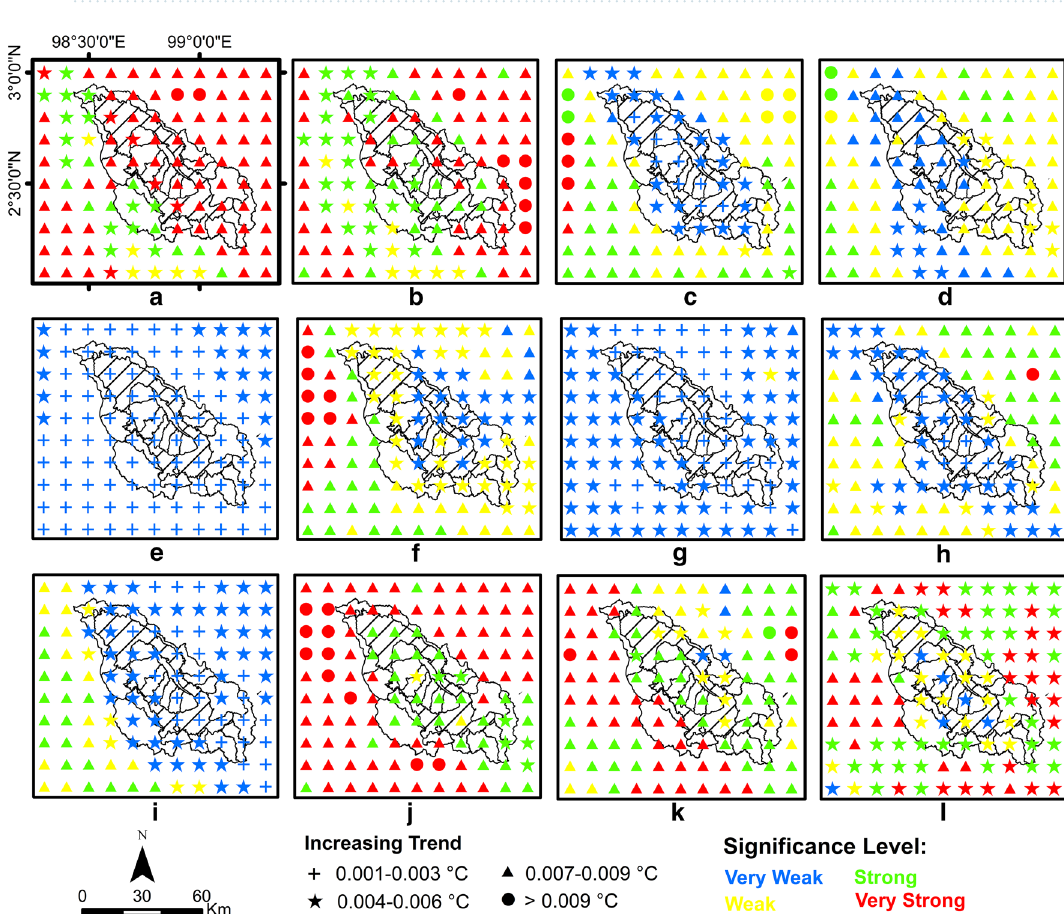
Figure 3. Spatial distribution of air temperature trends in the Lake Toba area for 1981–2020. In month ( a) December, ( b ) January, ( c ) February, ( d ) March, ( e ) April, ( f ) May, ( g ) June, ( h ) July, ( i ) August, ( j ) September, ( k ) October, and ( l )